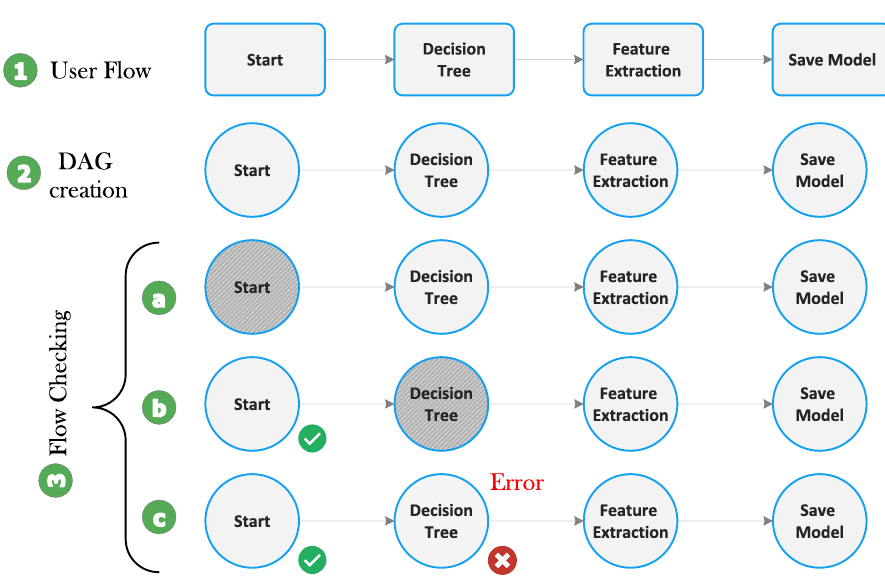
Figure 2. Flow-checking sequences for an invalid ML